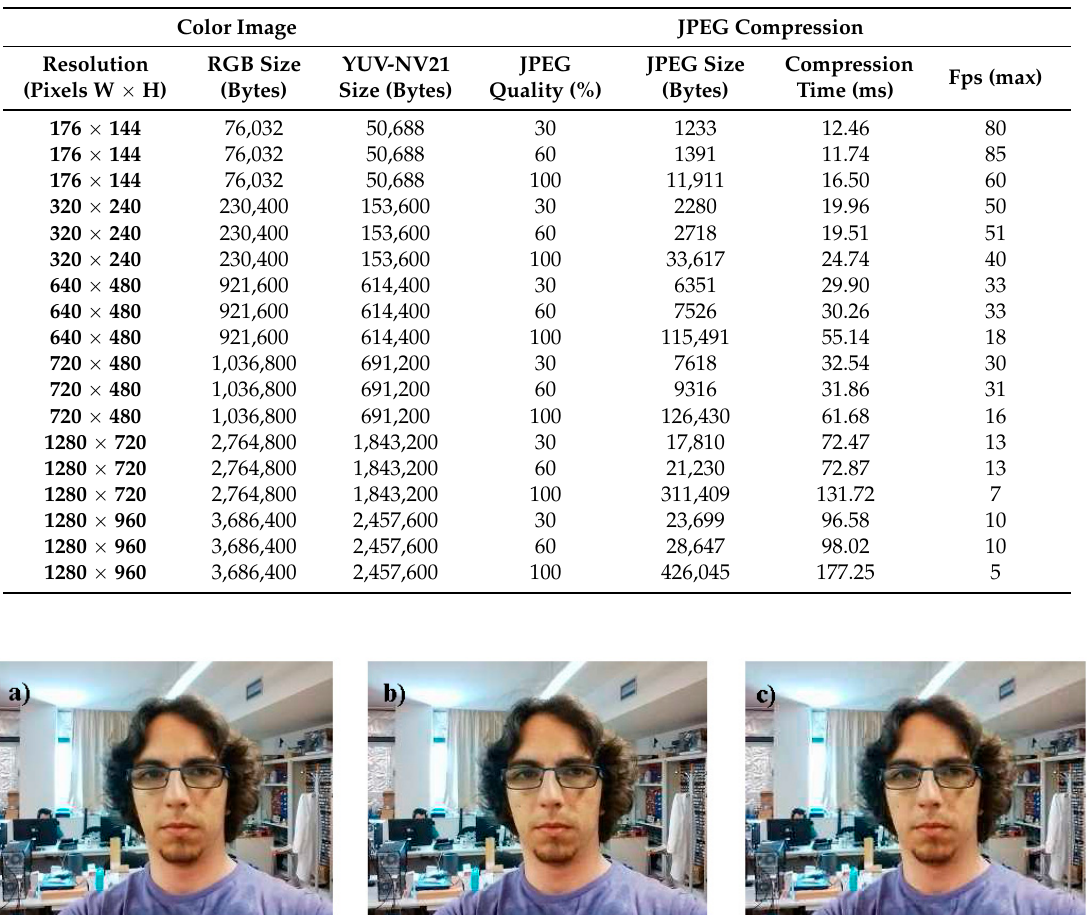
Table 5. Relationship between image size and JPEG quality.